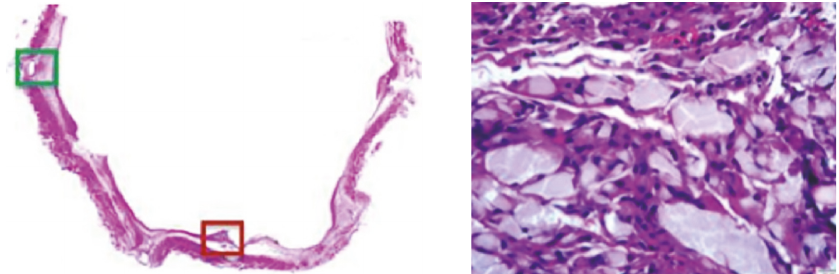
Figure 7: Representative high-power images from the histological analysis of the integration of the Sentry filter arms into the wall of the IVC. Left: section cut through the tips of the filter arms, stained with H&E. Right: view of residual PPDO filament material, surrounding chronic inflammatory cells adjacent to the fully incorporated tip of a filter arm (dark red box in the image at